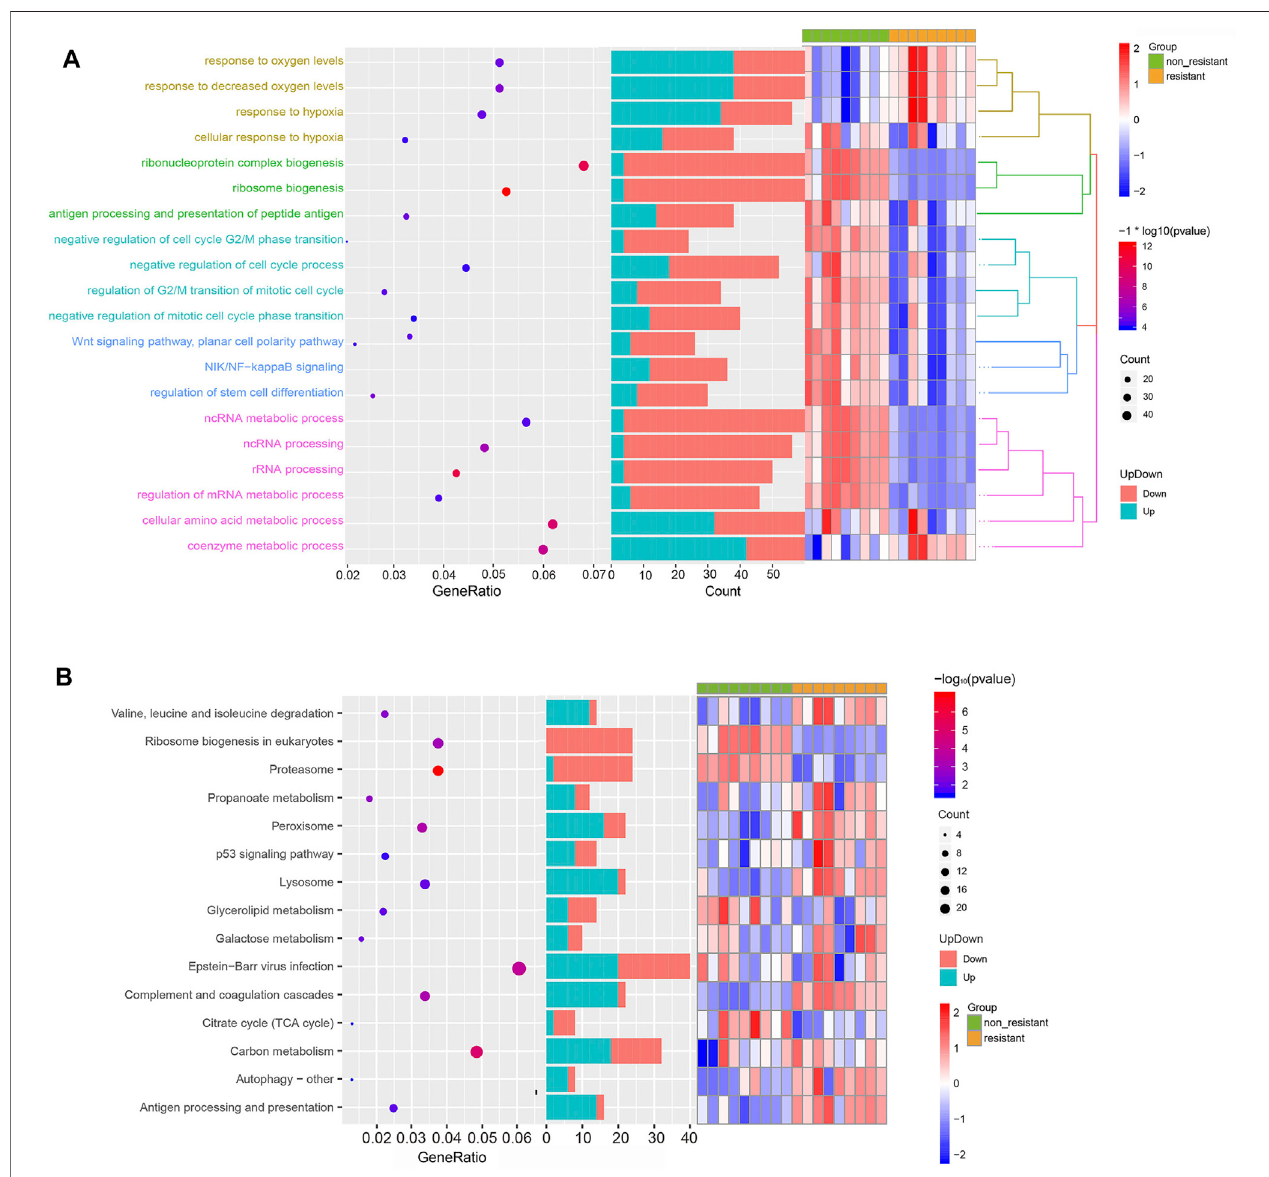
FIGURE 3| FunctionalenrichmentofDEGsrelatedtoNSCLCresistancetoEGFR-TKIs. (A) Top20signi fi cantGObiologicalprocesses. (B) Top15signi fi cantKEGGpathways.